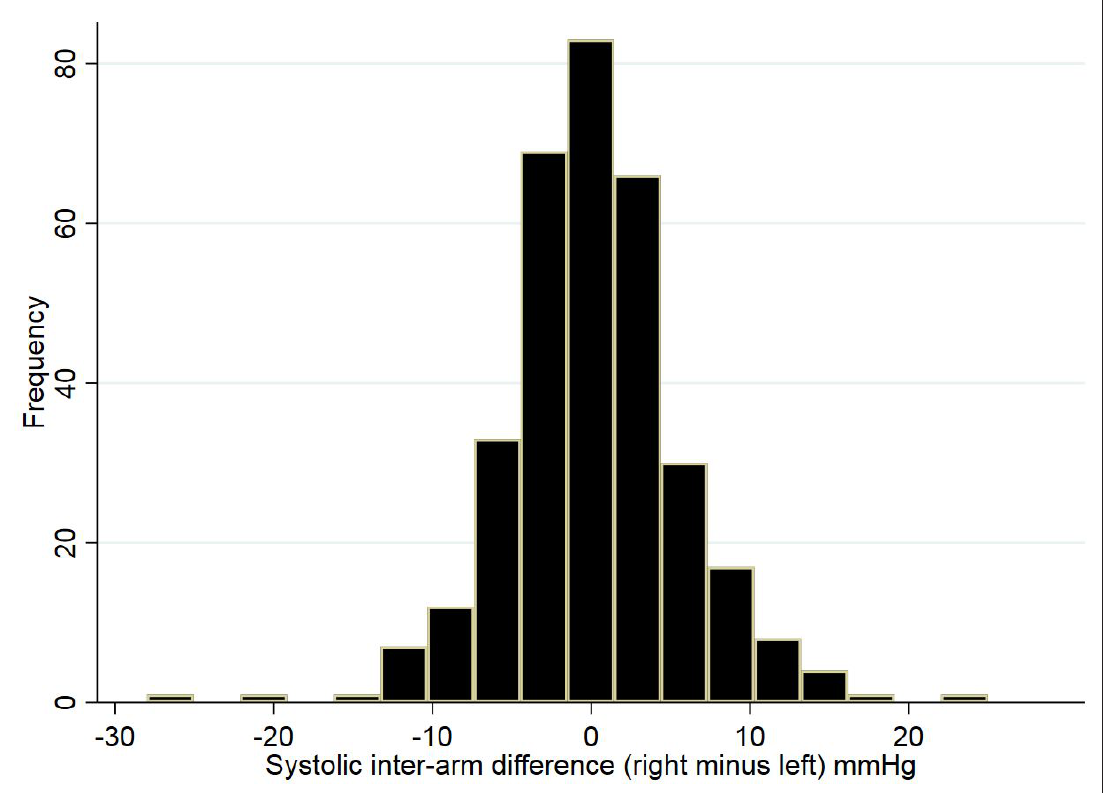
Figure 2 Distribution of systolic inter- arm difference for 334 participants at NHS Health